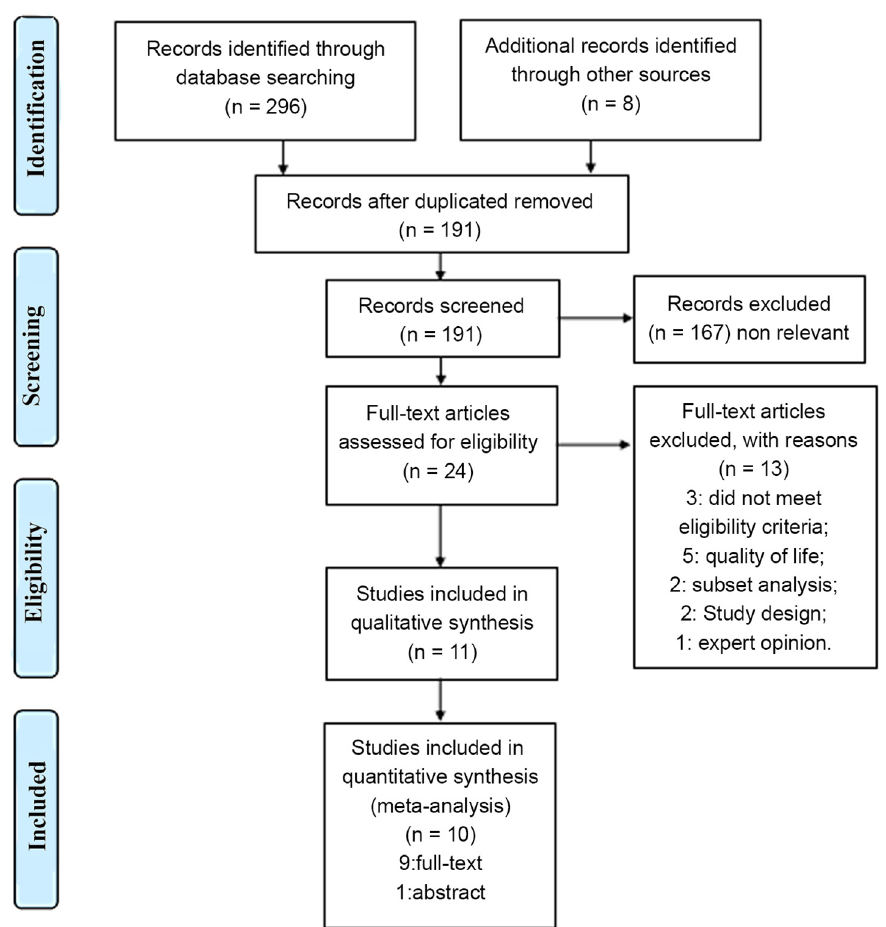
Fig 1. Flow diagram of the details of the